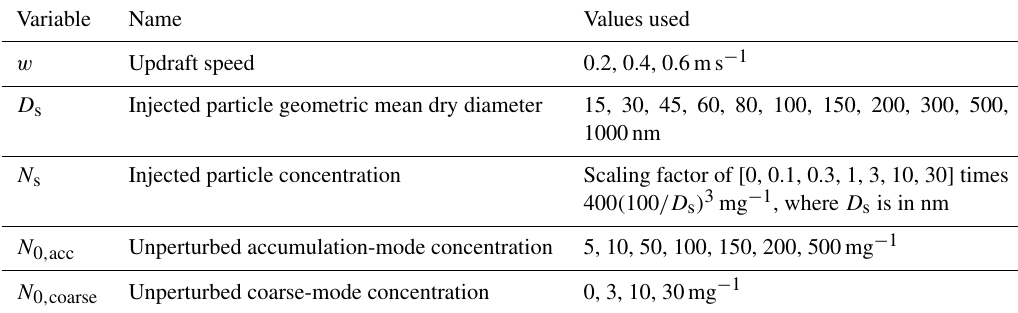
Table A1. Parameter values used to construct the activation look-up table.